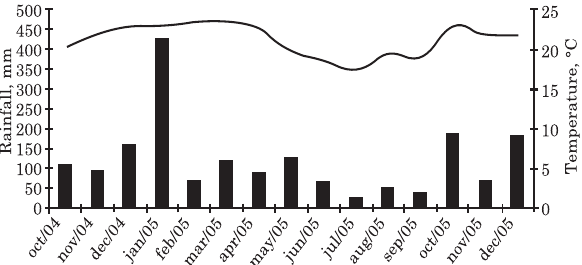
Figure 1. Total monthly rainfall ( ) and average monthly temperature (—) in the period of conducting the